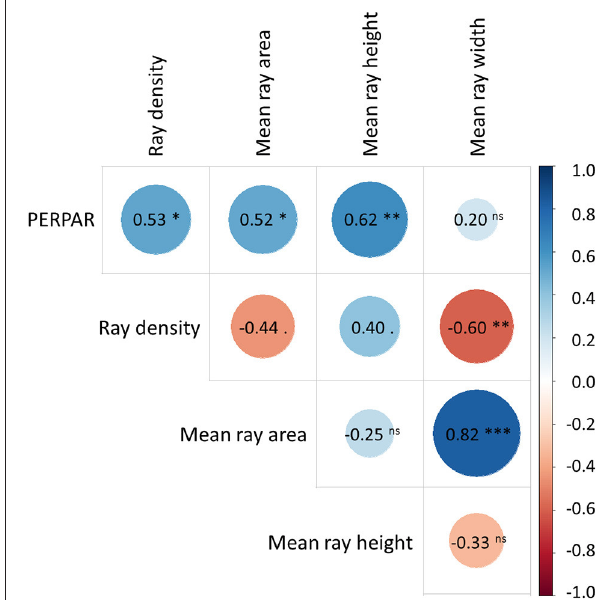
FIGURE 3 | Pearson’s correlation matrix between the ray parameters measured in tangential sections ( n = 18 ). The parameters include percentage of ray surface (PERPAR), ray density, mean ray area, mean ray height and mean ray width based on measurement from six mature Scots pine trees.Foreachtree,threelocationsseparatedbyfivetosevenannualringswere analyzed. *** P ≤ 0.001 ; ** P ≤ 0.01 ; * P ≤ 0.05 ; · P ≤ 0.1 ; ns, not